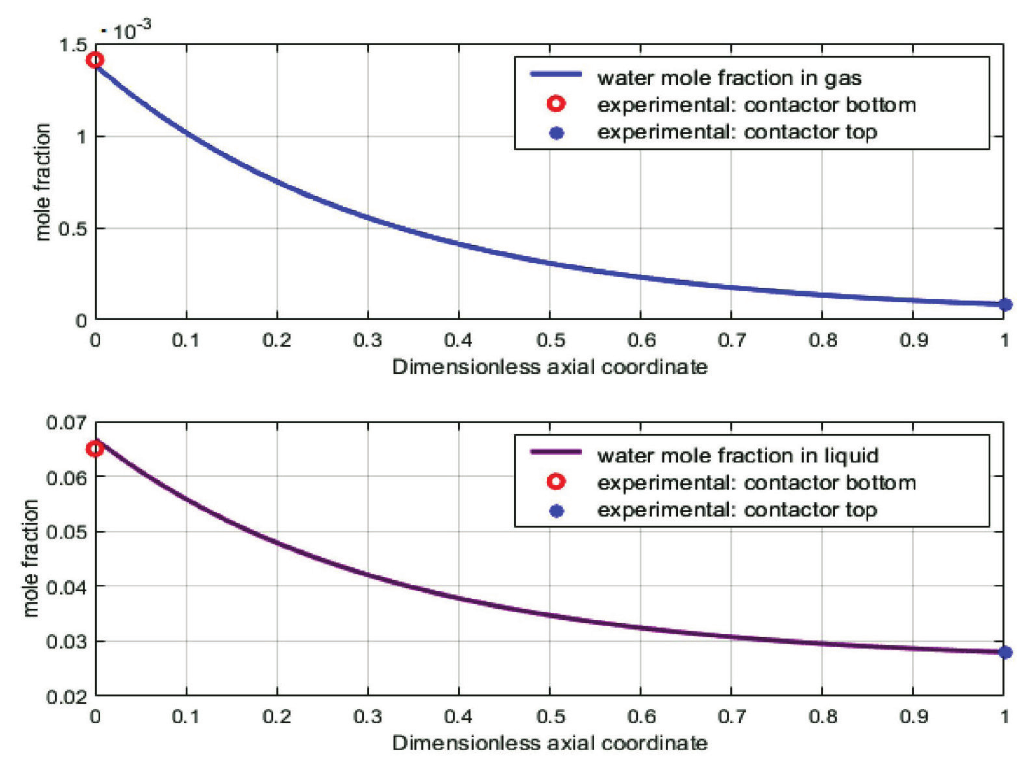
Fig. 7a – Example 2. Composition profiles (water mole fraction) of gas and liquid